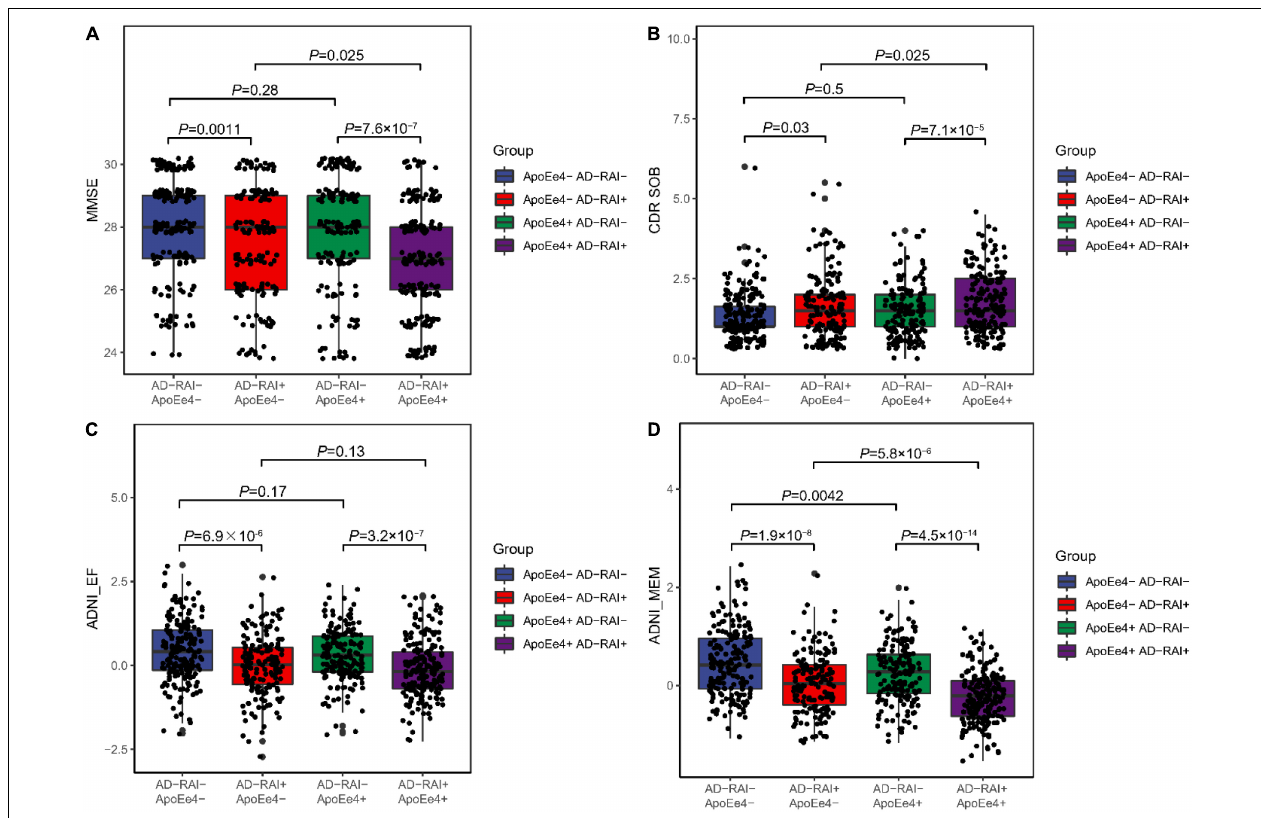
FIGURE 1 | Associations of AD-RAI and APOE ε 4 with cognitive measures among MCI patients. We categorized the participants into four groups: APOE- ε 4+ plus AD-RAI-positive group (AD-RAI + APOE- ε 4+), only APOE- ε 4+ group (AD- RAI-, APOE- ε -4+), only AD-RAI-positive group (AD-RAI + APOE- ε 4-) and both negative group (AD- RAI-, APOE- ε 4-). We found that scores of MMSE (A) , ADNI-EF (C) and ADNI-MEM (D) were significantly higher in the two AD-RAI-positive groups. We also observed better memory performance (D) in the two APOE- ε 4+ groups. The APOE- ε 4+ plus AD-RAI-positive group performed better in CDR-SOB test than the only APOE- ε 4+ group (B) . (PS: Jittering was used to avoid severe dot overlap). TABLE 3 | Baseline associations of AD-RAI and APOE status with cognitive measures. Independent Statistics MMSE CDR-SOB ADNI-EF ADNI-MEM Factors APOE Status, ε 4